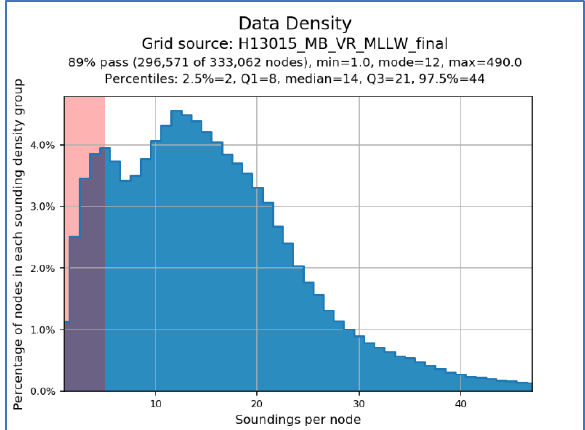
Figure 7. Grid QA output for data density. The histogram shows the percentage of total nodes that contain a specific sounding per node. To pass the density test, 95% of the nodes must have at least 5 soundings contributing to the population of that node [13]. The histogram bins with less than 5 soundings are in red. Therefore, in this example, this grid does not pass the density test; as noted in the title section of the figure, only 89% of the nodes pass this